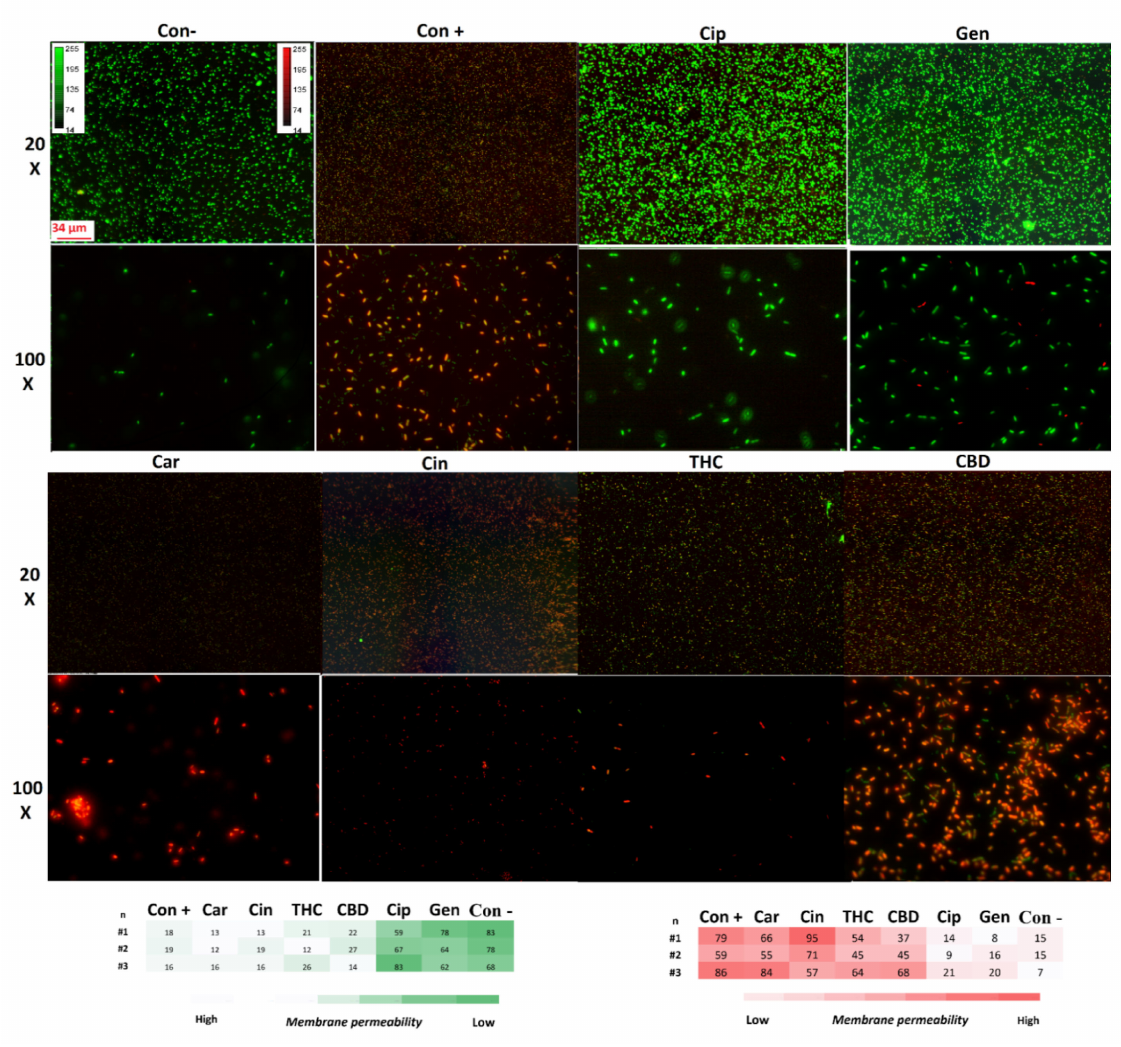
Figure 3. The fluorescence microscopy of PI-staining of P. aeruginosa exposed with selected PBCs, antibiotics, and controls for 1 h. Higher red fluorescence has higher membrane disruption and permeability. The densitometry and intensity measurement heat map is shown in the bottom panel ( n = 3). Con+: control-positive (bacteria boiled for 10 min to disrupt the membrane); Con − : control- negative (untreated); Cin: cinnamaldehyde; THC: tetrahydrocannabinol; CBD: cannabidiol; Cip: ciprofloxacin; Gen: